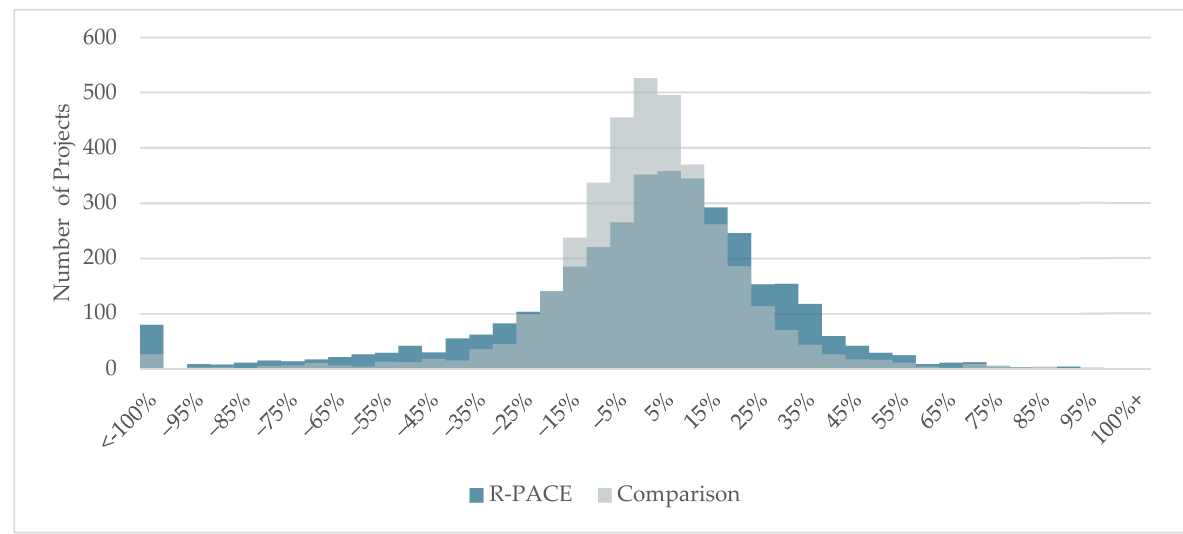
Figure 6. Distribution of household gas savings from HVAC projects. Note that positive numbers represent savings (reductions in gas use); negative numbers are negative savings (increases in gas use).